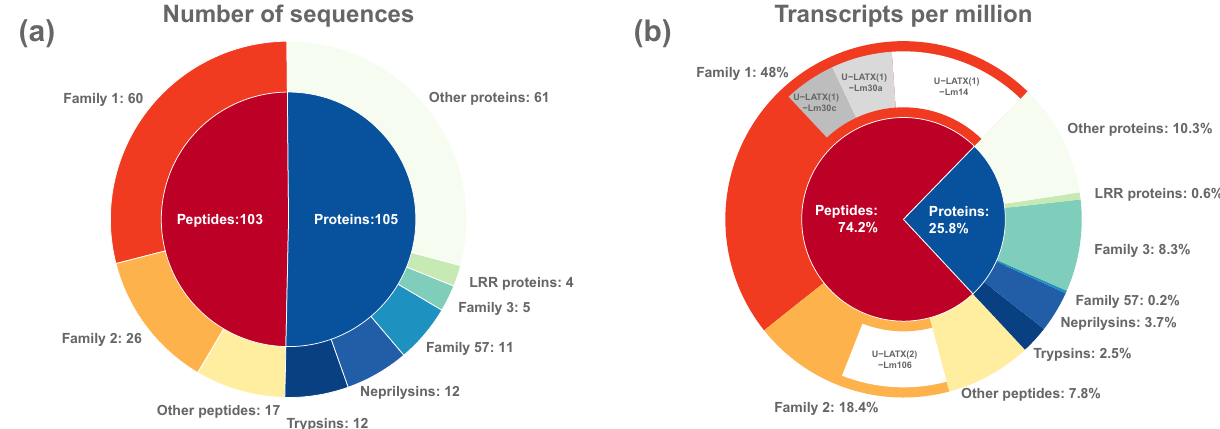
Figure 1. Diversity and abundance of components in the Lampona venom proteome. ( a ) The number of different components in the venom proteome. ( b ) Relative abundance of components in Lampona venom (based on TPM). The four most abundant toxins, each representing > 5% of total TPM, are